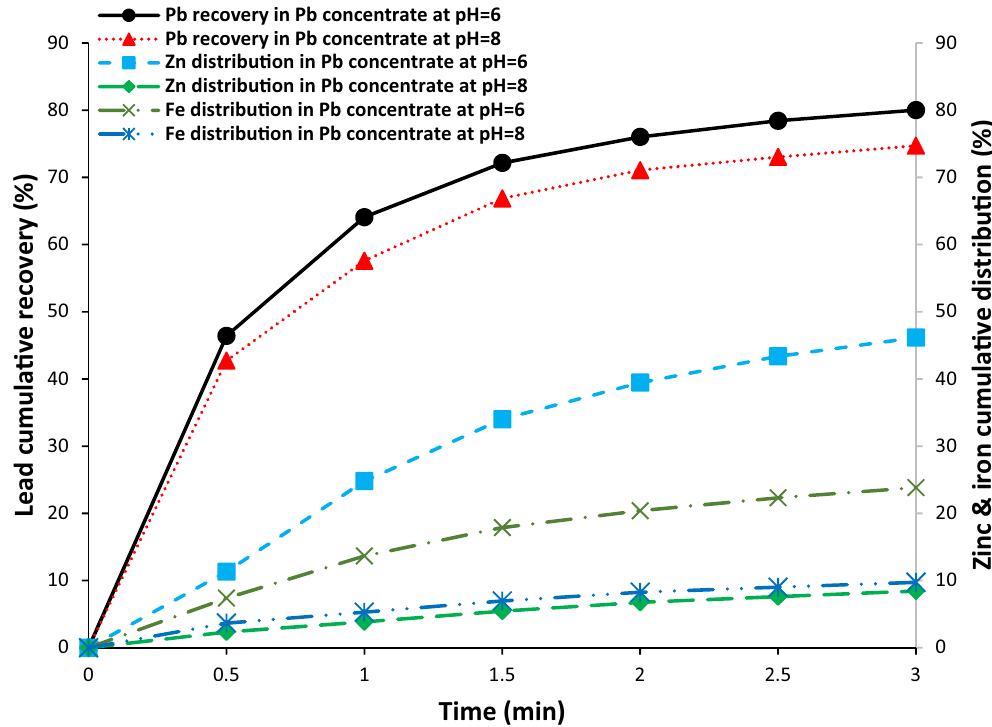
Figure 10. Flotation kinetic of lead, zinc, and iron at pH of 6 and 8 in the lead flotation stage.